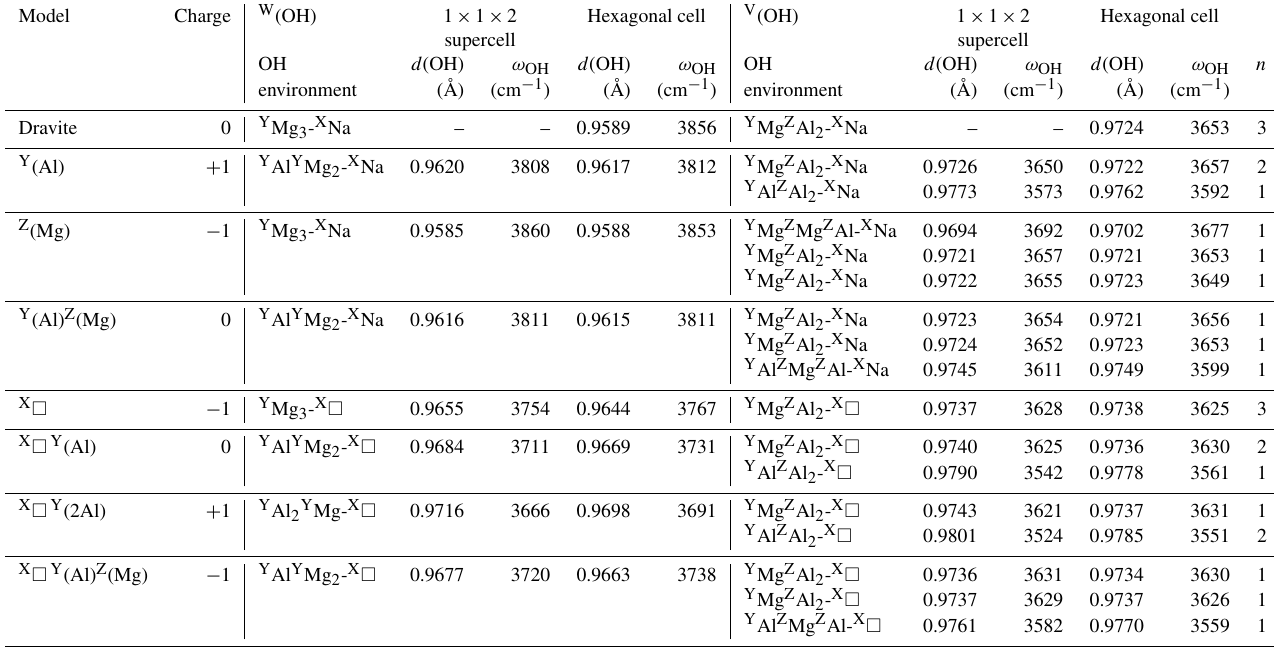
Table 1. Local charge imbalance, theoretical OH stretching frequencies ( ω OH ) and theoretical O–H distances ( d (OH)) in dravite models obtained using the hexagonal cell or a larger 1 × 1 × 2 hexagonal supercell.